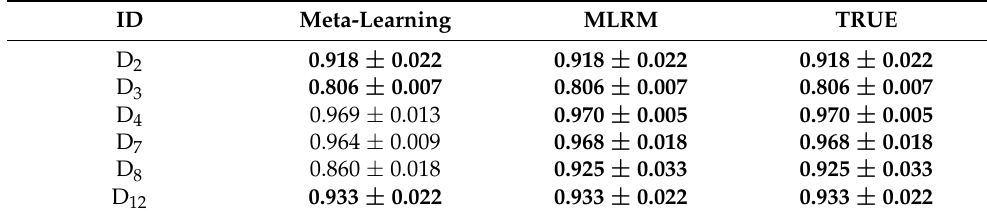
Table 14. Accuracy comparison between MLRM and meta-learning in